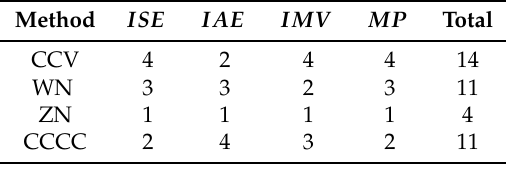
All units are points.